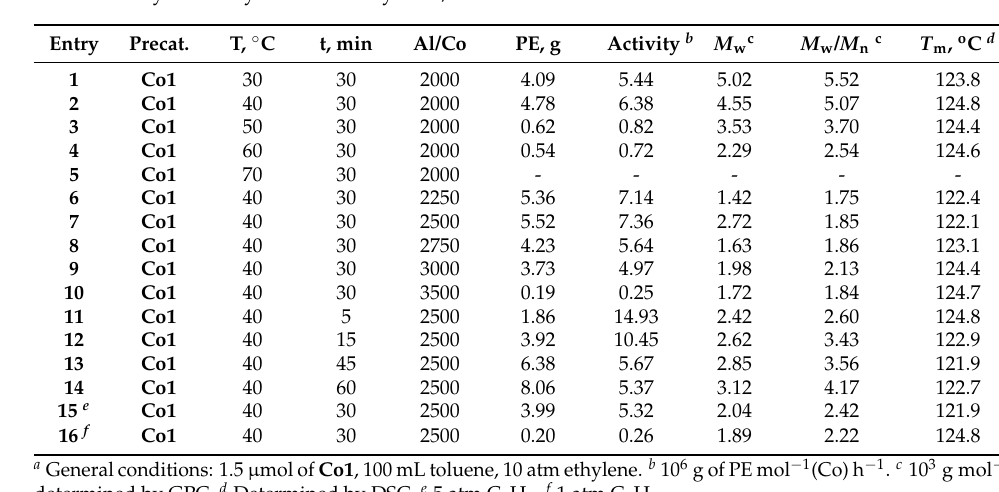
Table 2. Ethylene Polymerization by Co1 /MAO under the conditions a .